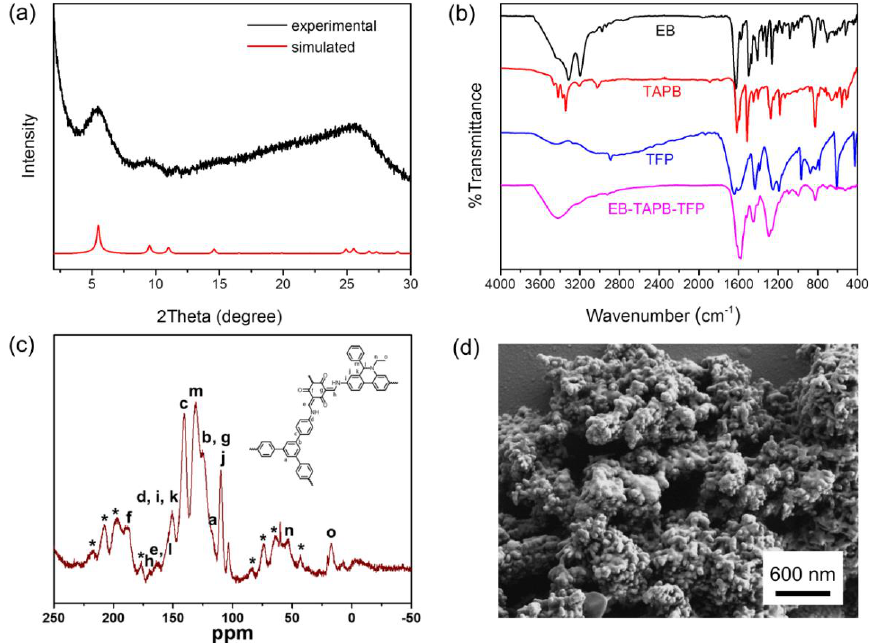
Figure 1. ( a ) The simulated and experimental PXRD patterns of EB − TAPB − TFP COF. ( b ) The FT − IR spectra of the starting materials of EB, TAPB and TFP, as well as EB − TAPB − TFP COF. ( c ) Solid − state 13 C CP − MAS NMR spectrum of EB − TAPB − TFP COF. The asterisks (*) indicate the spinning side bands. ( d ) SEM image of EB − TAPB − TFP COF.